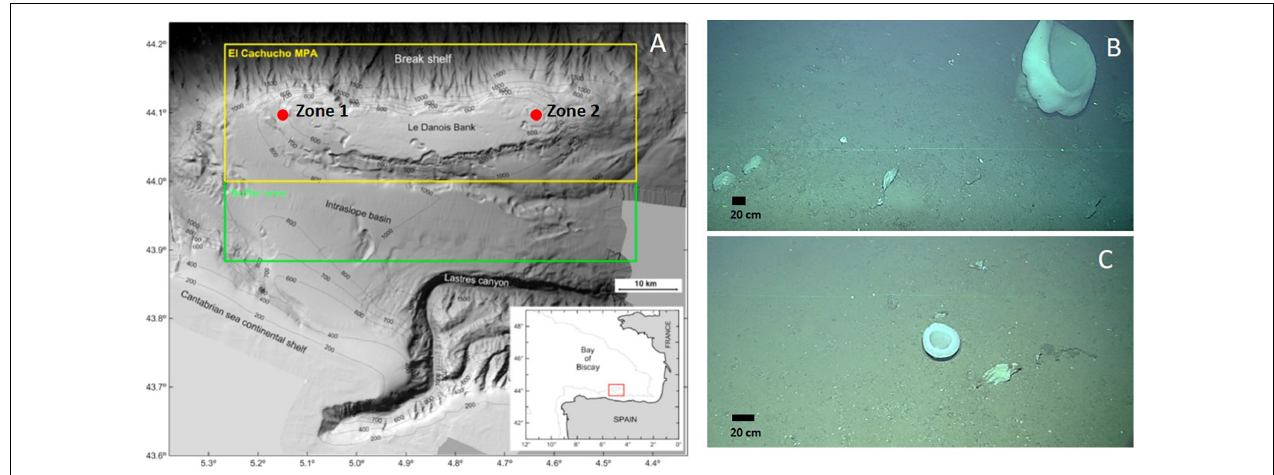
FIGURE 1 | (A) Location of “El Cachucho” MPA on the Bay of Biscay, and some topographic features that characterize the area. Red dots show the location of study zones with specimens of A. setubalense analyzed in this study. (B) Example of A. setubalense specimen in study zone 1: large A. setubalense specimens, no small specimens were recorded; (C) zone 2, specimens of small and medium size, no large specimens were recorded. Scales of the images were calculated from the constant spacing of the laser beams (20 cm).